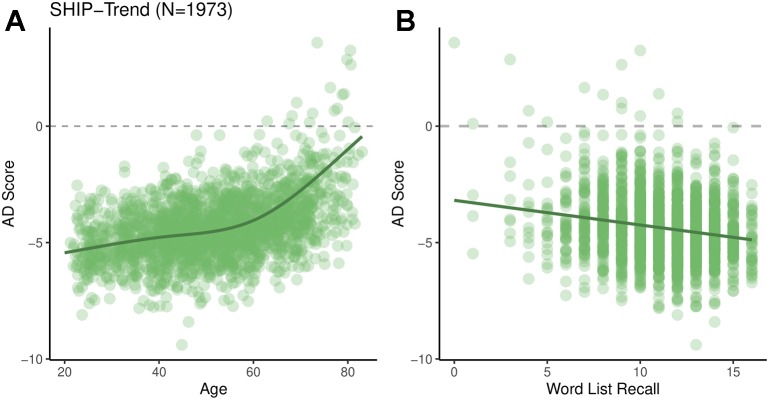
AD scores for the SHIP-Trend sample plotted against chronological age (A) and the overall word list recall score (B).